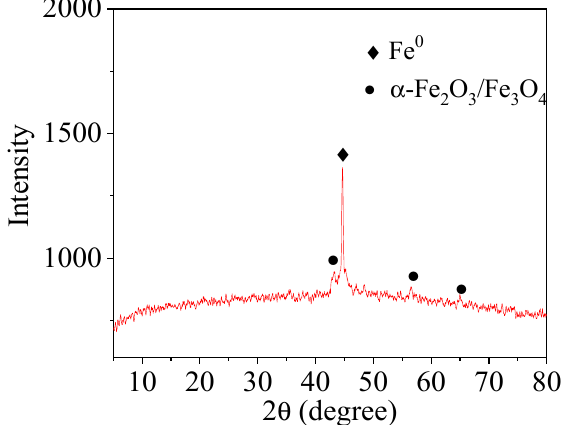
Figure 2. The XRD spectrogram of nZVI.